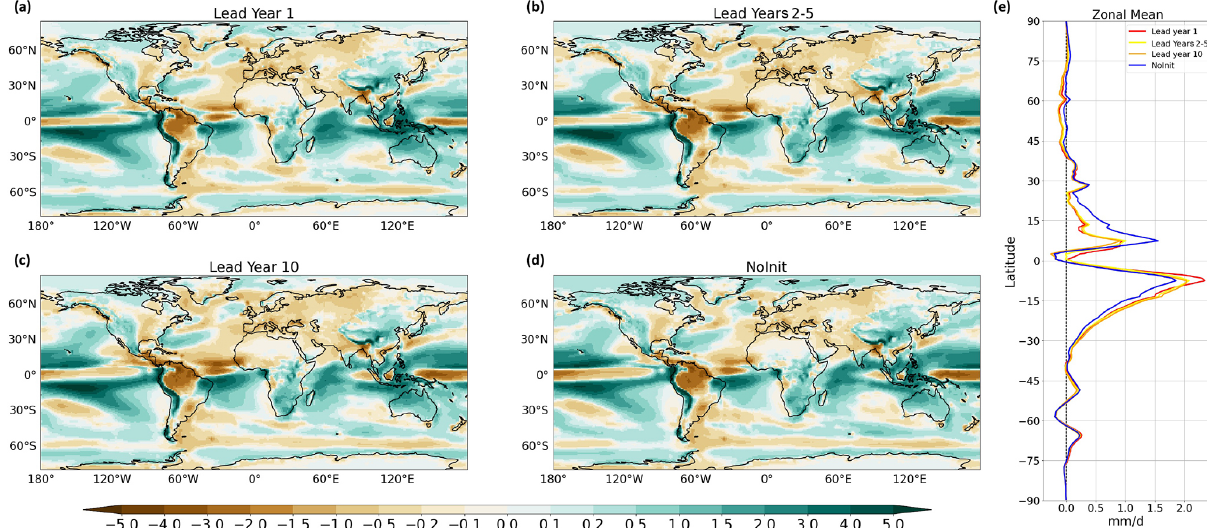
Figure 7. Mean precipitation bias for (a) year 1, (b) years 2–5, (c) year 10, (d) NoInit runs, and (e) their zonal mean (scaled with the cosine of the latitude) with respect to the 1960–2020 period from GPCC dataset (Schneider et al., 2020). The unit is millimeters per day (mmd − 1